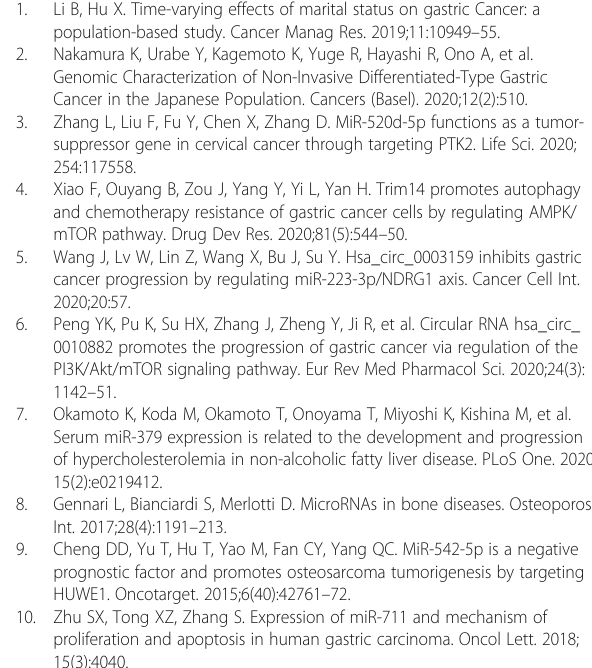
Abbreviations GCa: Gastric cancer; miRNAs: microRNAs; NC: Negative control; qRT- PCR: Quantitative real-time